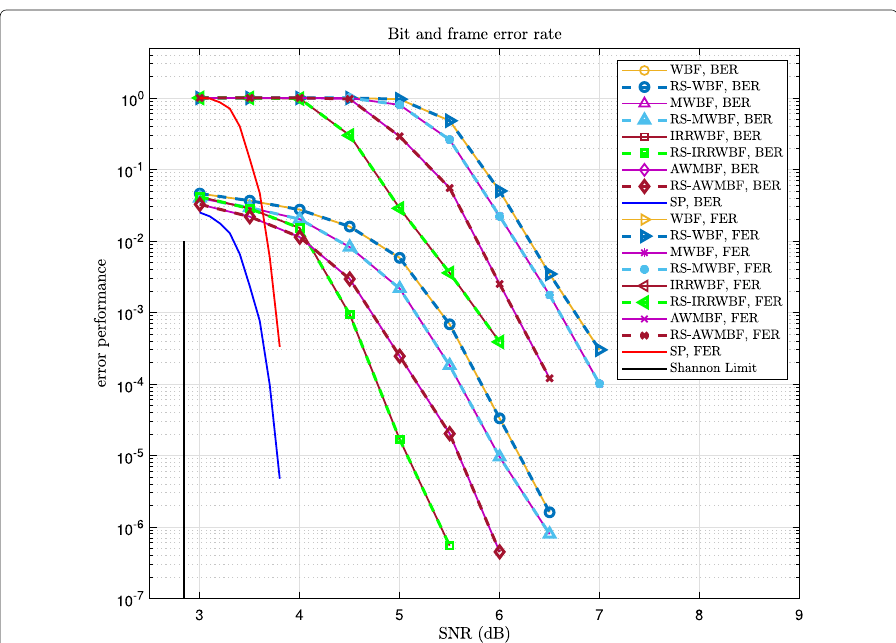
Fig. 8 Performance of (4,32)-regular LDPC code with rate 7